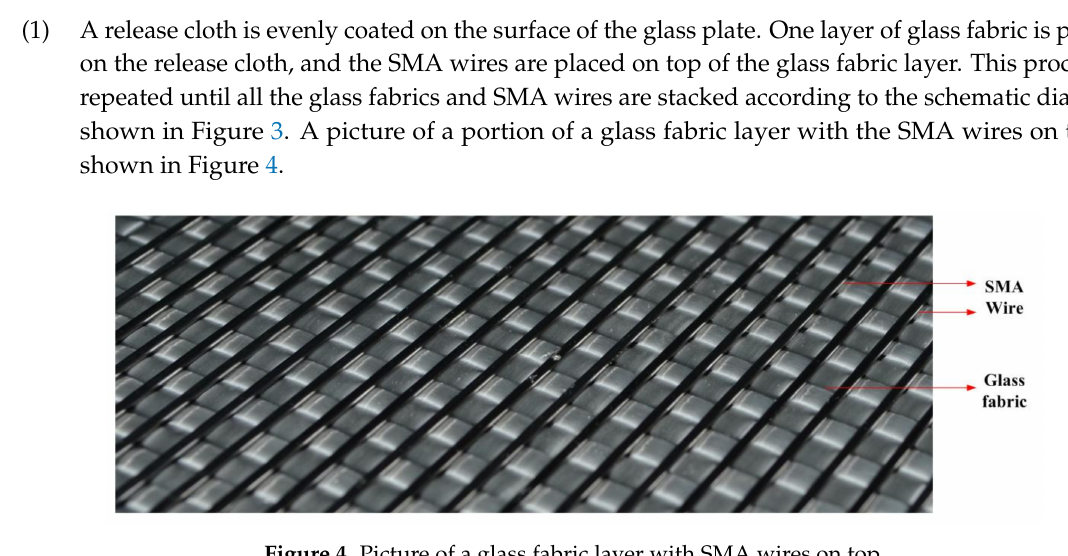
Figure 4. Picture of a glass fabric layer with SMA wires on top.